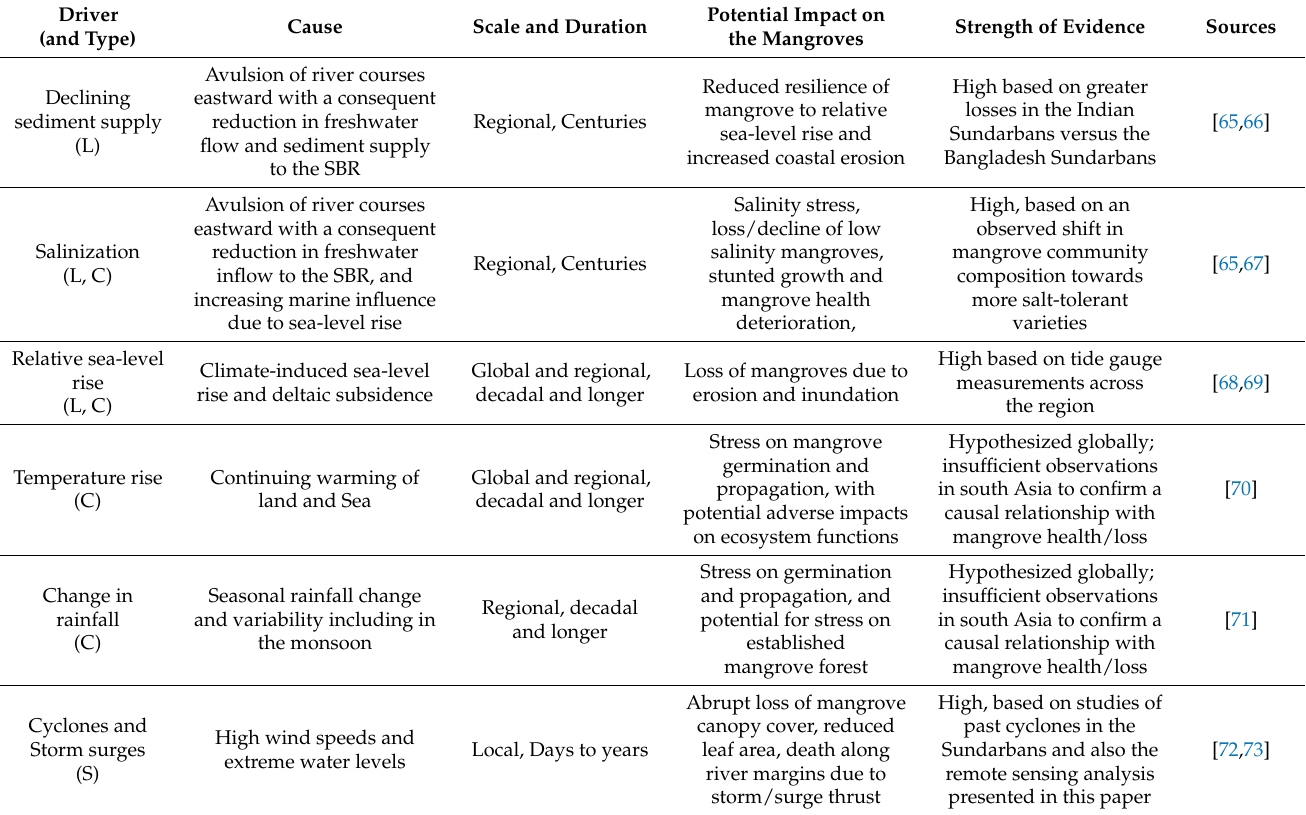
Table 4. Drivers of change for mangroves in the Indian Sundarbans. Driver types: L—legacy; C—contemporary; S—shock. Driver (and